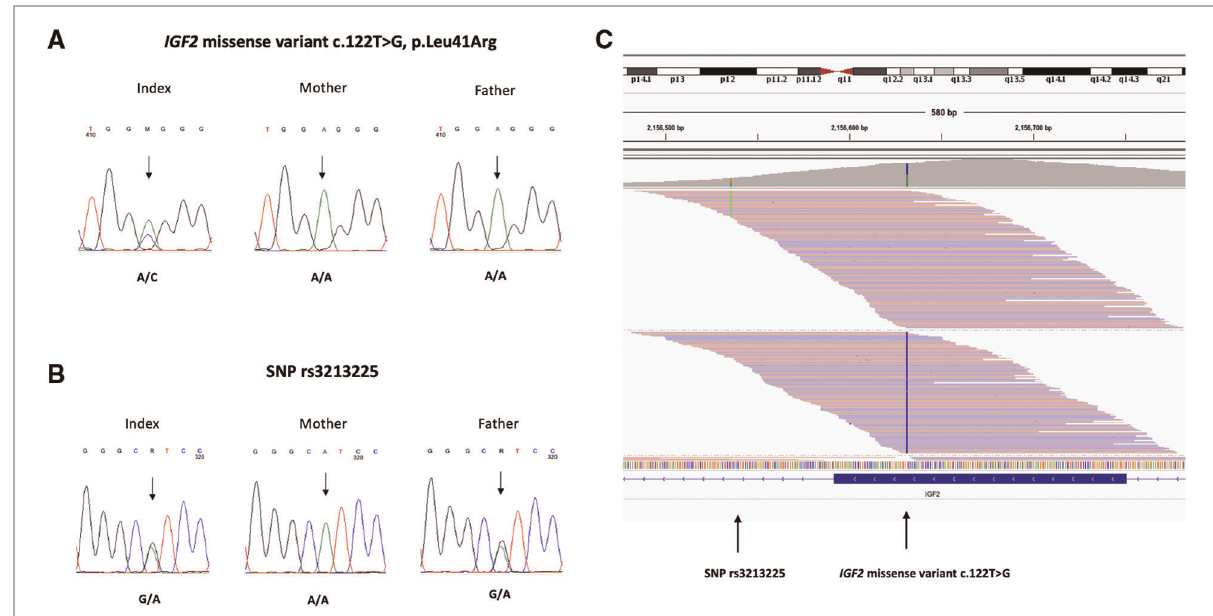
FIGURE 3 ( A ) Chromatograms of direct sequence analysis of IGF2 gene showing the missense variant c.122T>G, p.Leu41Arg in the patient ( B ) the SNP rs3213225 in the patient and father ( C ) IGV view of the patient ’ s sequence data shows that the reads with SNP alternative allele A (in green) and the missense variant c.122T>G (in blue) are on different reads. The father is heterozygous (G/A) for the SNP and the mother is homozygous (A/ A). The reads with the SNP reference allele G, that also carry the missense variant c.122T>G, must be paternal.